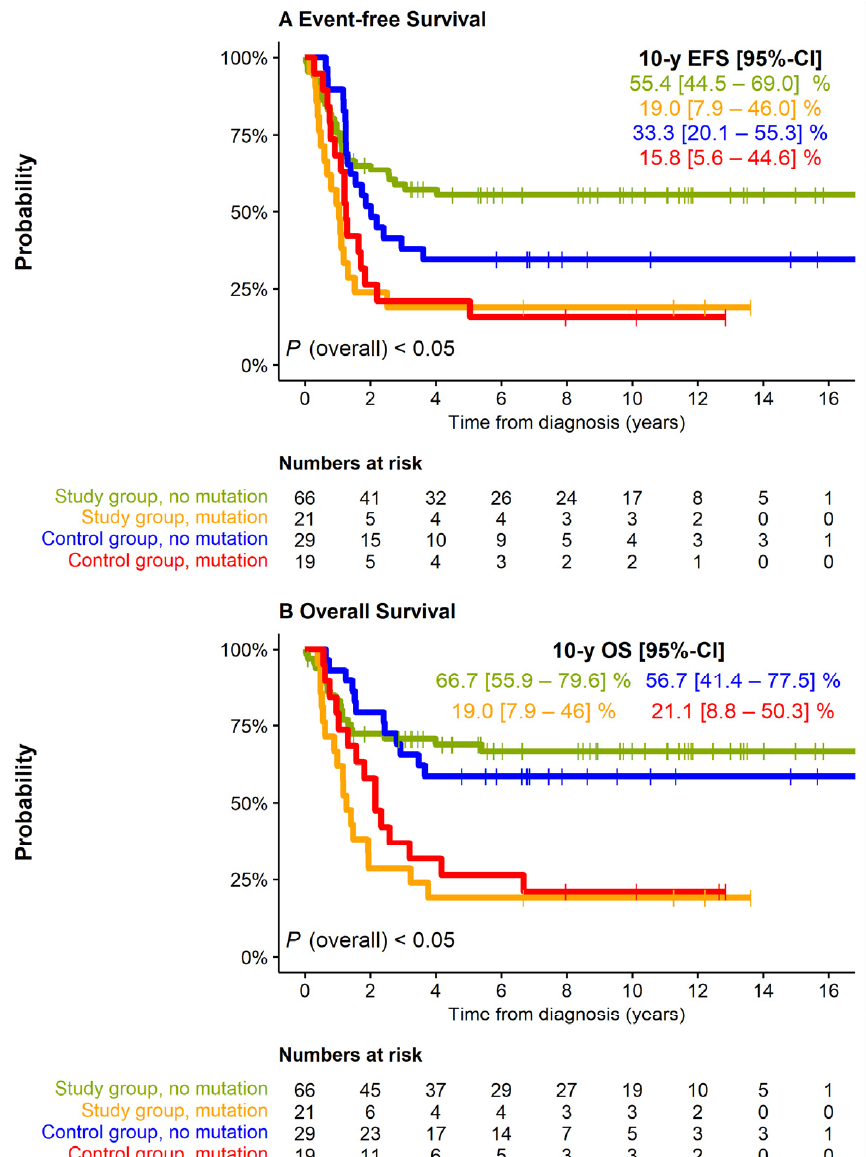
Figure 3. EFS and OS of 87 study group ( N = 87) and control group ( N = 39) patients by the presence of mutations in the genes of the RAS and p53 pathways (including ALK). ( A ): EFS, ( B ): OS. Pairwise comparisons (Log-rank p -values, Bonferroni–Holm adjusted). EFS: Study group, no mutation vs. study group, mutation: 0.003. Study group, no mutation vs. control group, no mutation: N.A. (lines cross). Study group, no mutation vs. control group, mutation: 0.012. Study group, mutation vs. control group, no mutation: 0.028. Study group, mutation vs. control group, mutation: 0.510. Control group, no mutation vs. control group, mutation: 0.094. OS: Study group, no mutation vs. study group, mutation: <0.001. Study group, no mutation vs. control group, no mutation: N.A. (lines cross). Study group, no mutation vs. control group, mutation: 0.003. Study group, mutation vs. control group, no mutation: 0.001. Study group, mutation vs. control group, mutation: 0.393. Control group, no mutation vs. control group, mutation: 0.013.